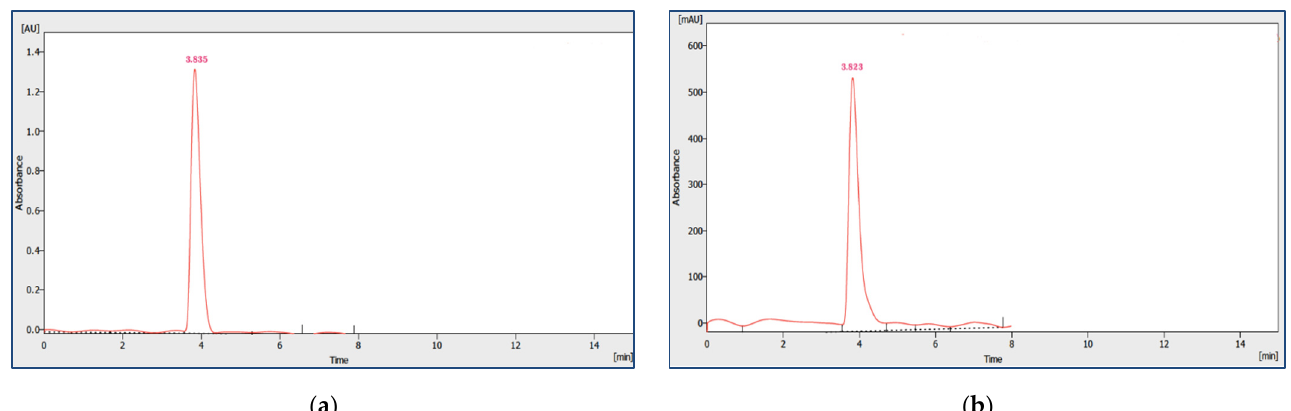
Figure 1. ( a ) HPLC chromatogram of HMF standard; ( b ) HPLC chromatogram of HMF content of the biscuit sample (BSC2-U) which showed the highest level of HMF.